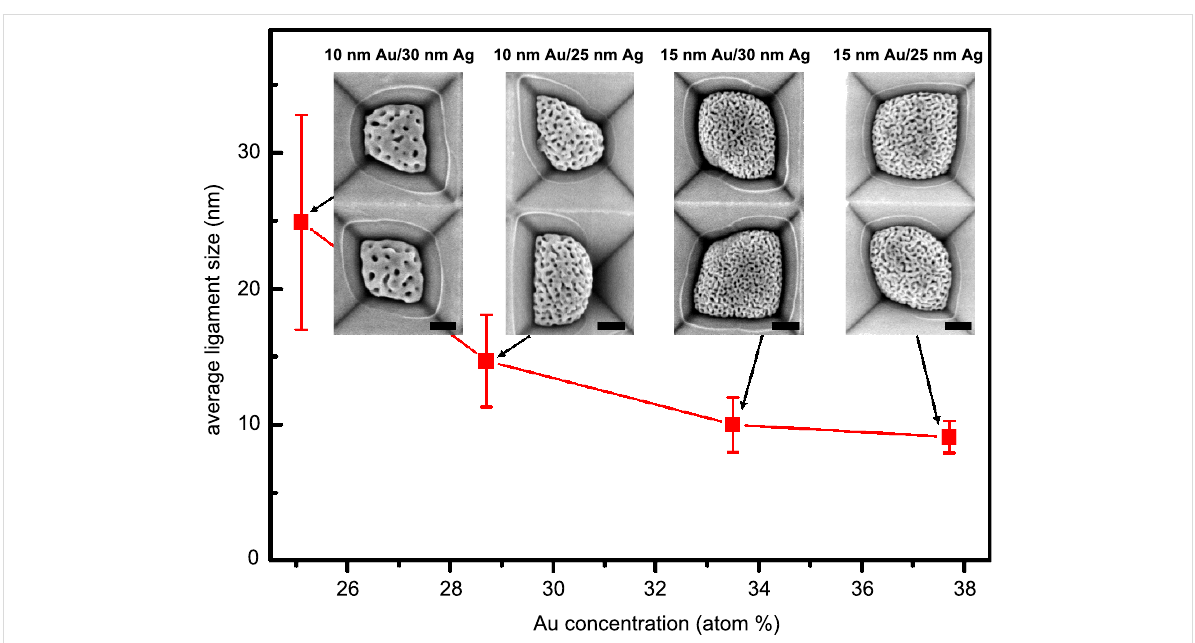
Figure 4: Plot of the average ligament size as a function of the Au concentration of alloy nanoparticles. The error bars represent the standard devia- tion. Insets show the corresponding SEM images. Scale bars in the insets are 100 nm.